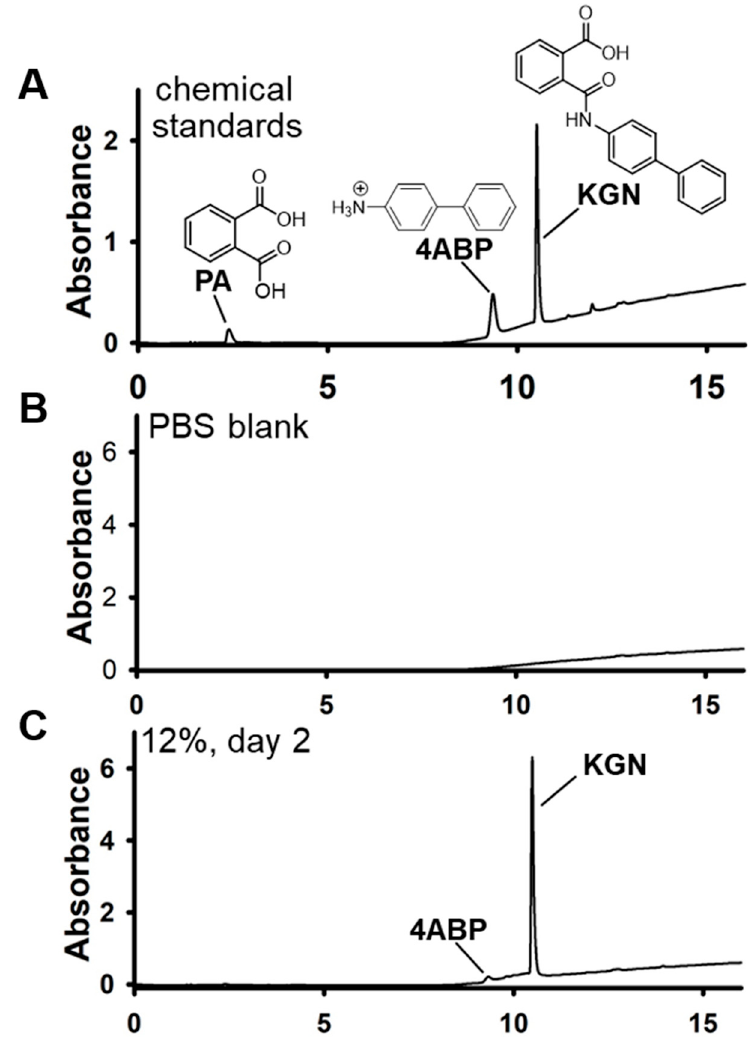
Figure 5. Reversed-phase HPLC-PDA chromatograms of soaked scaffolds. PDA parameters: 200–